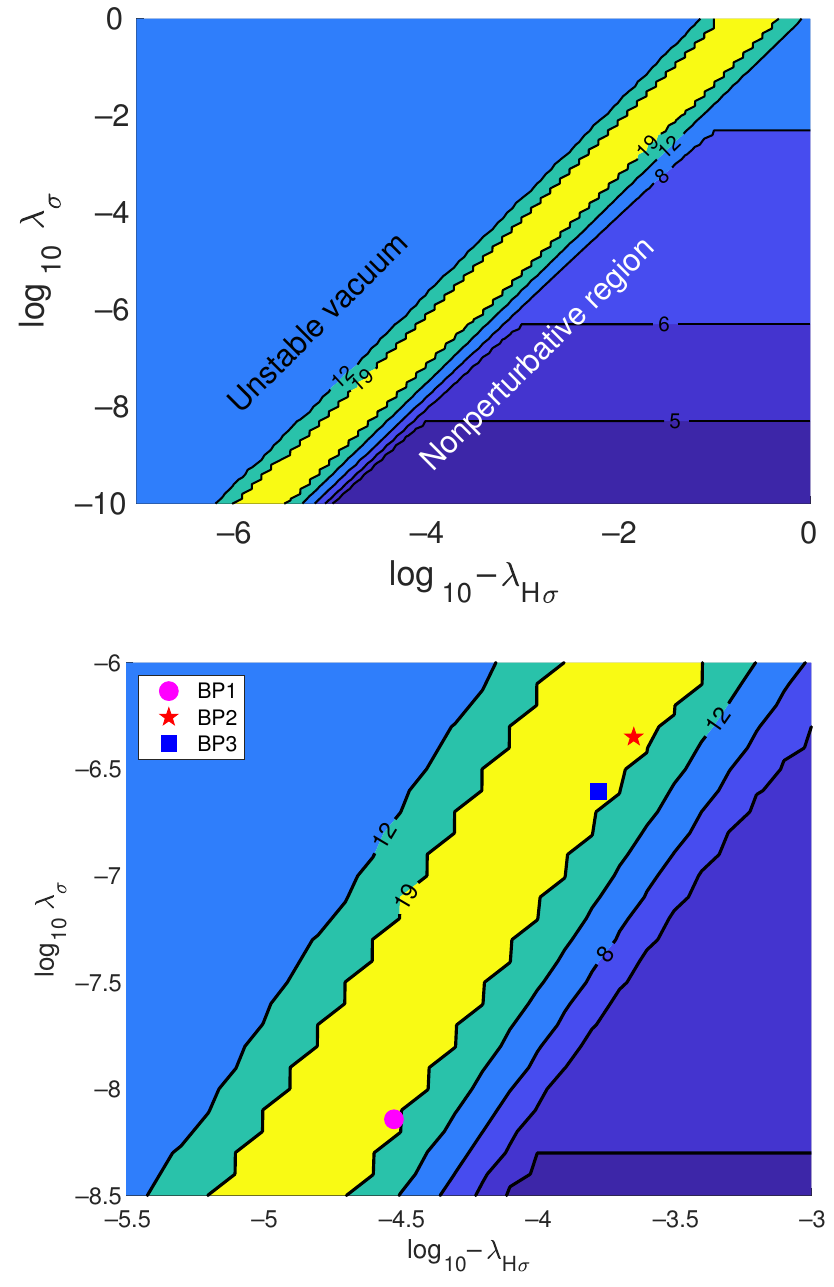
Figure 9. ( Above ): Different regions in the logarithmic ( − λ H σ , λ σ ) plane. The contour numbers n above the yellow band correspond to the vacuum instability scale 10 n GeV. Below the yellow band, the contour numbers m correspond to the non-perturbative scale 10 m GeV. The color coding is interpreted as in Figure 6. For non-perturbative scale calculations, we used BP1 . ( Below ): Zoomed-in detail of the figure above, showing in addition our chosen